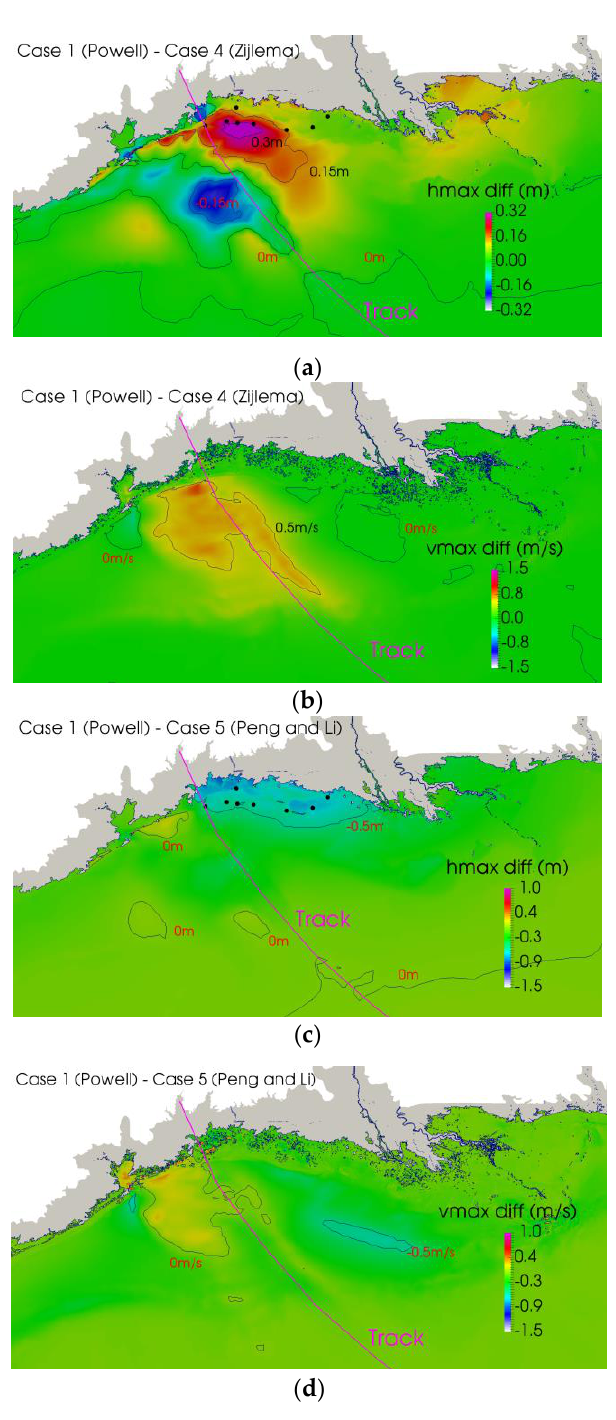
Figure 5. Contour plots of maximum water elevation for hindcast of Hurricane Rita storm surges. ( a ) maximum elevation difference: Case 1–Case 4; ( b ) maximum velocity difference: Case 1–Case 4; ( c ) maximum elevation difference: Case 1–Case 5; ( d ) maximum velocity difference: Case 1–Case 5.